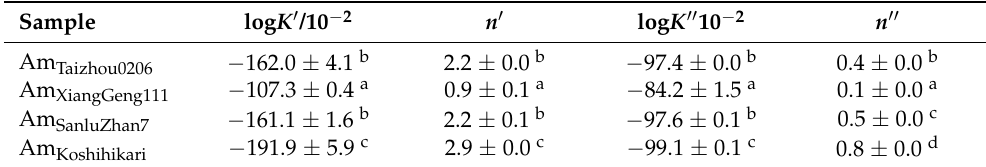
Table 3. Power-law model fitting parameters.